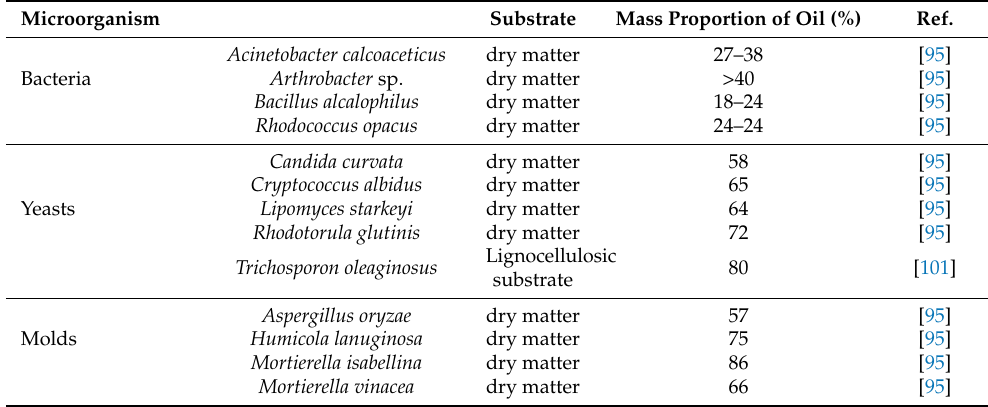
Table 3. Yields of lipids from different microorganisms.